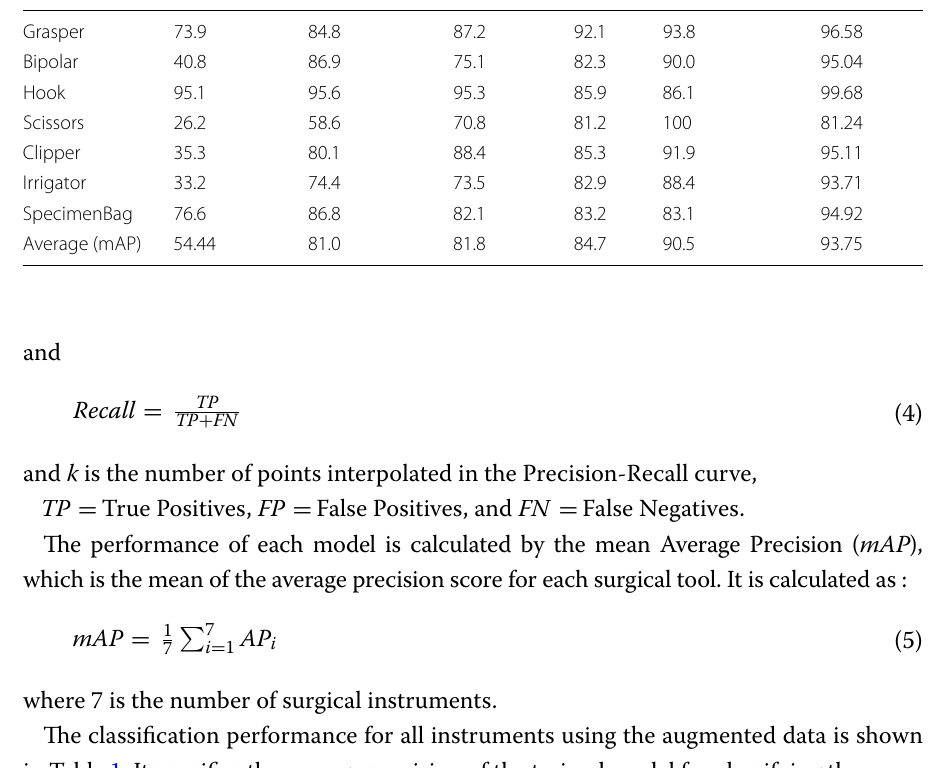
Table 2 Comparison of the Average precision (AP) for all tools with other models Tool